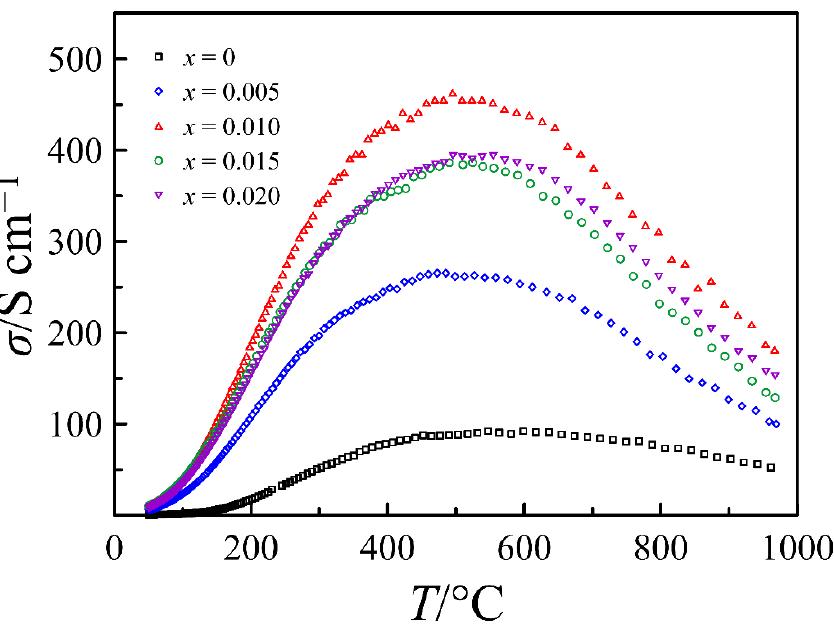
Figure 4. Electrical conductivity of La 0.5 − x Sr 0.5 FeO 3 − δ ceramics sintered at 1300 °C, measured in air versus temperature.